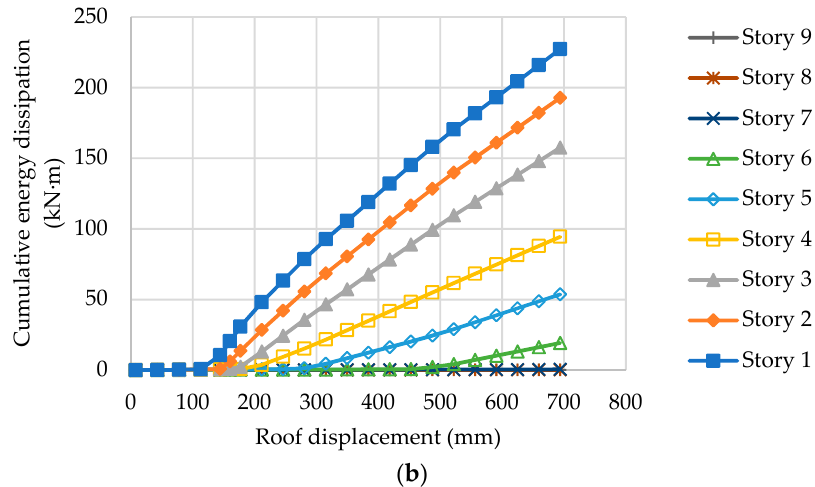
Figure 10. Cumulative energy dissipation response under ( a ) LD-P and ( b ) LD-U. Figure 11 counts the cumulative energy dissipated in each story under both load distributions.